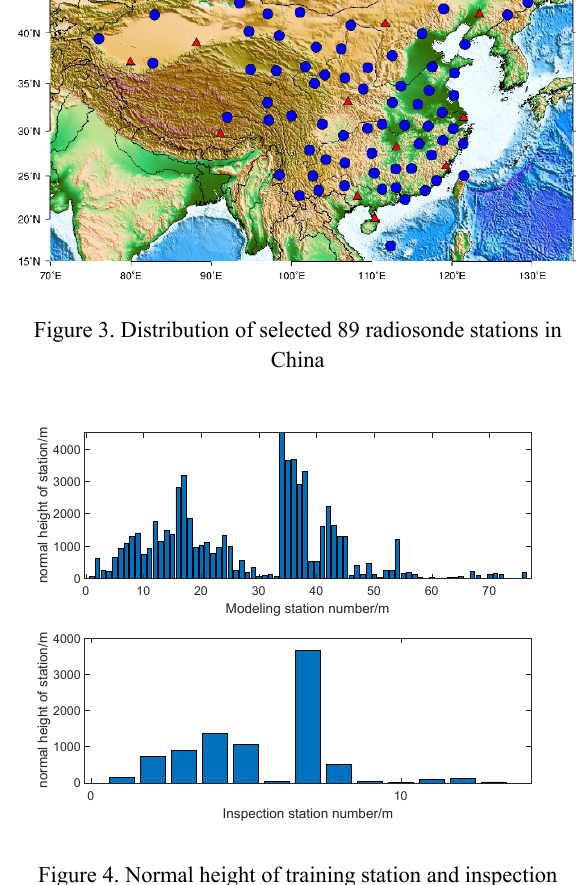
Figure 4. Normal height of training station and inspection station